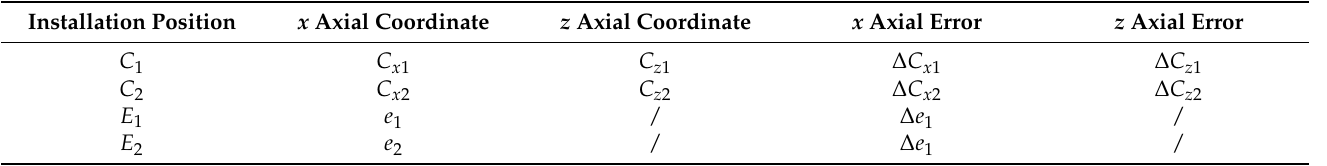
Table 2. Position source error of press transmission